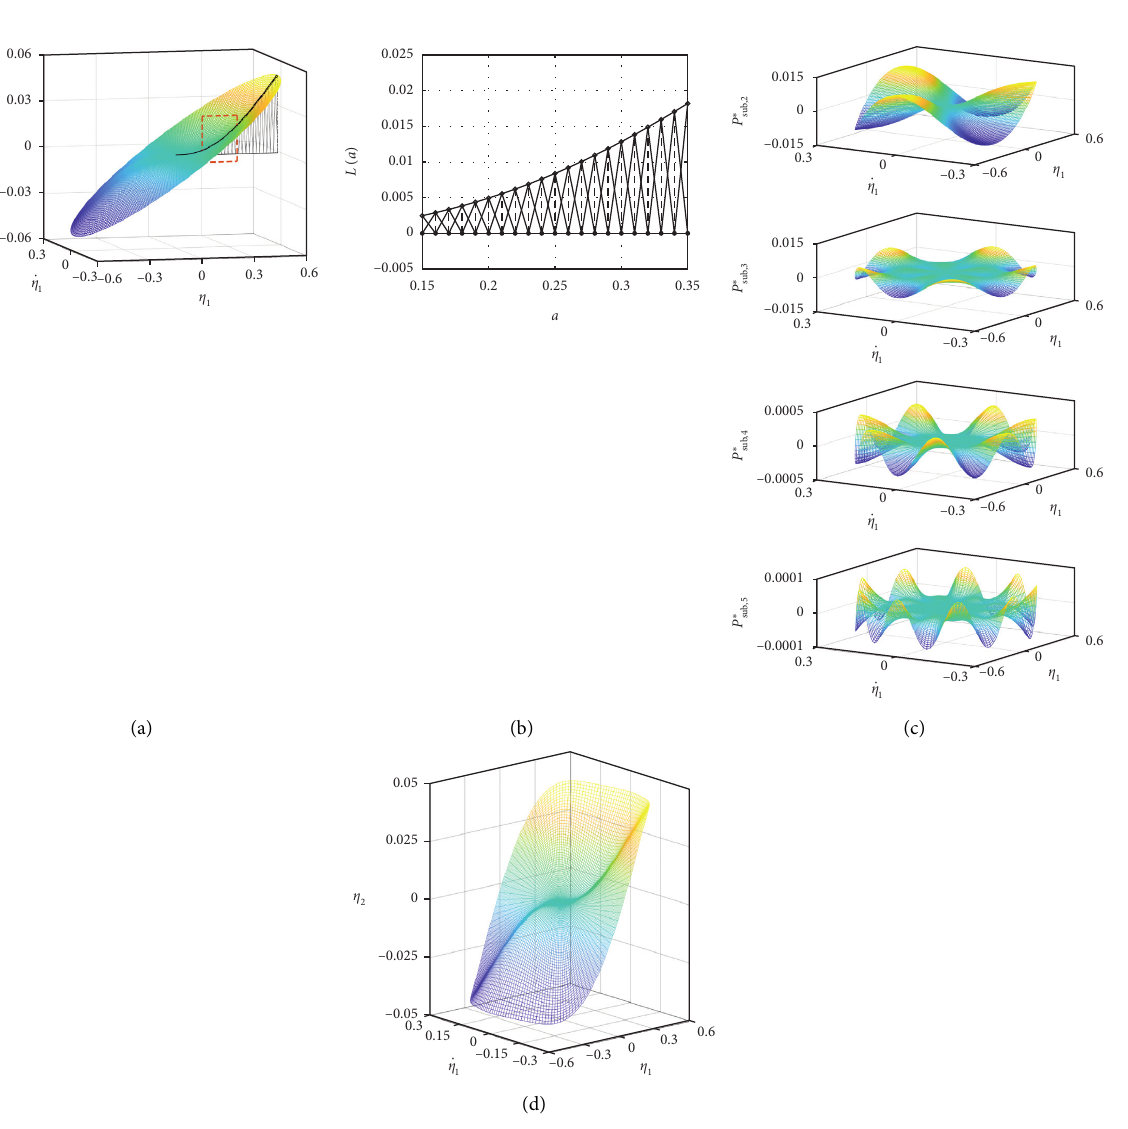
Figure 4: Schematic diagram of the approximate expansion of NNM invariant manifold: (a) subsurface component P ∗ approximation, P ∗ (c) subsurface components of NNM approximation, P ∗ resultant superposition of all subsurface components, as the approximation of this NNM manifold η